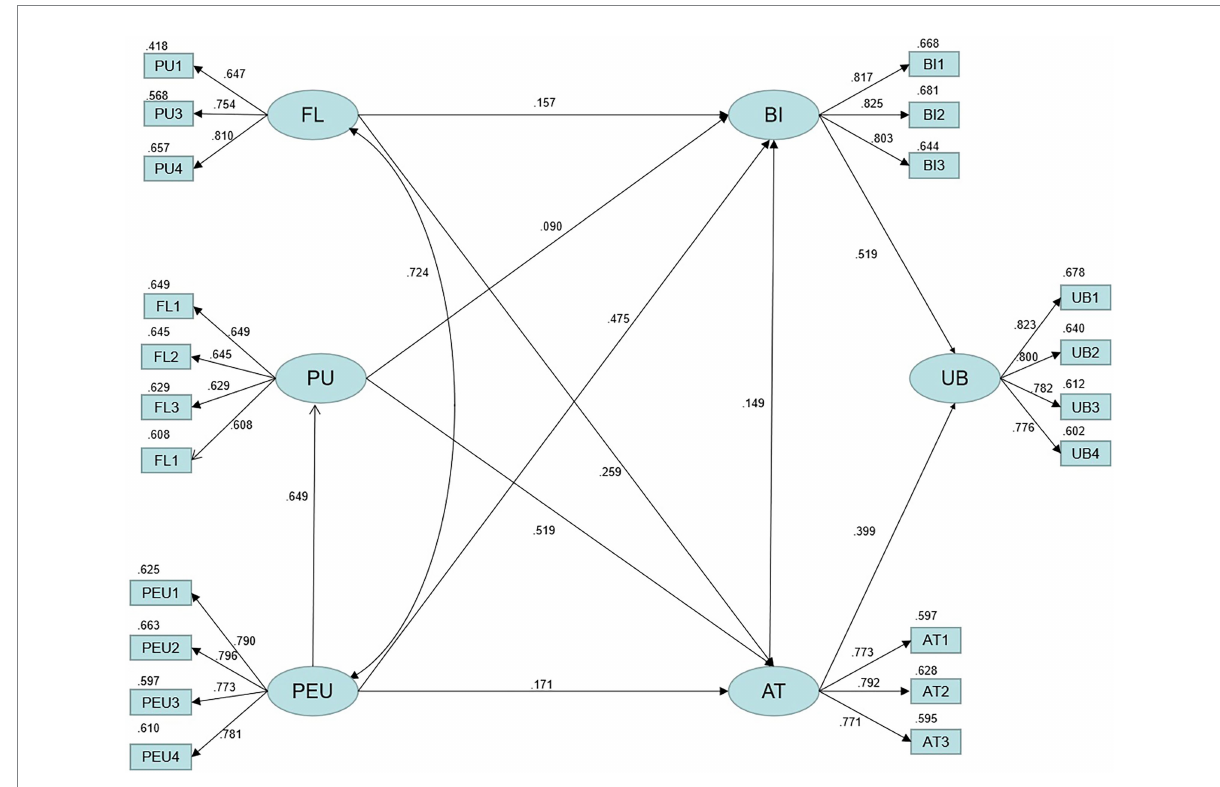
FIGURE 1 Structural equation model.